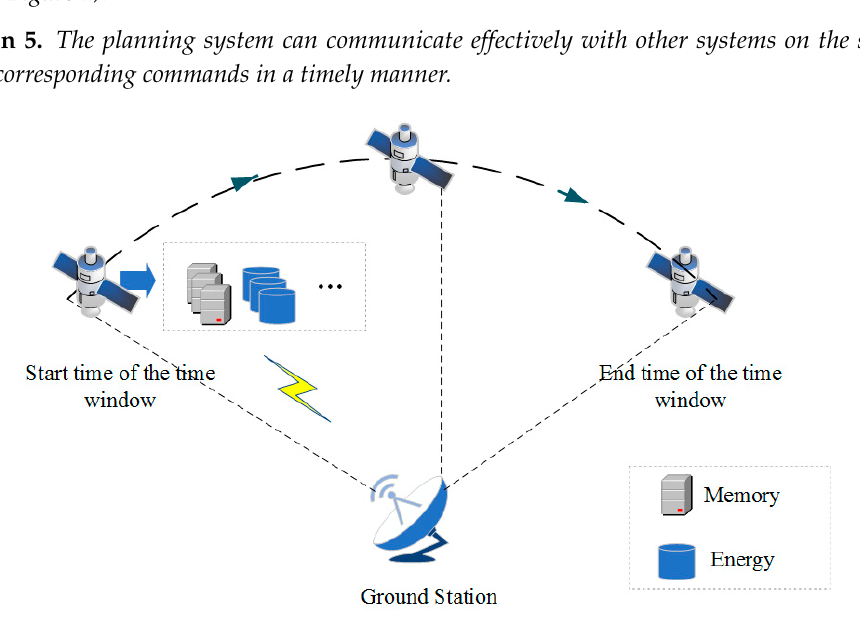
Figure 1. Data-downloading tasks.